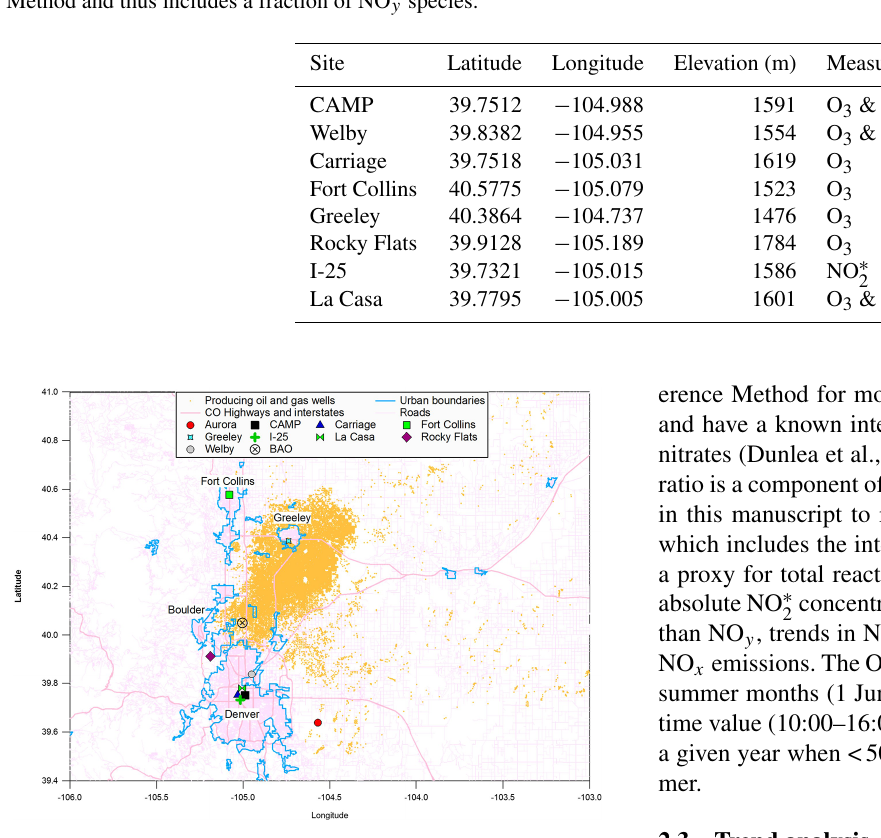
refers to the NO 2 detected by the EPA Federal Reference 2